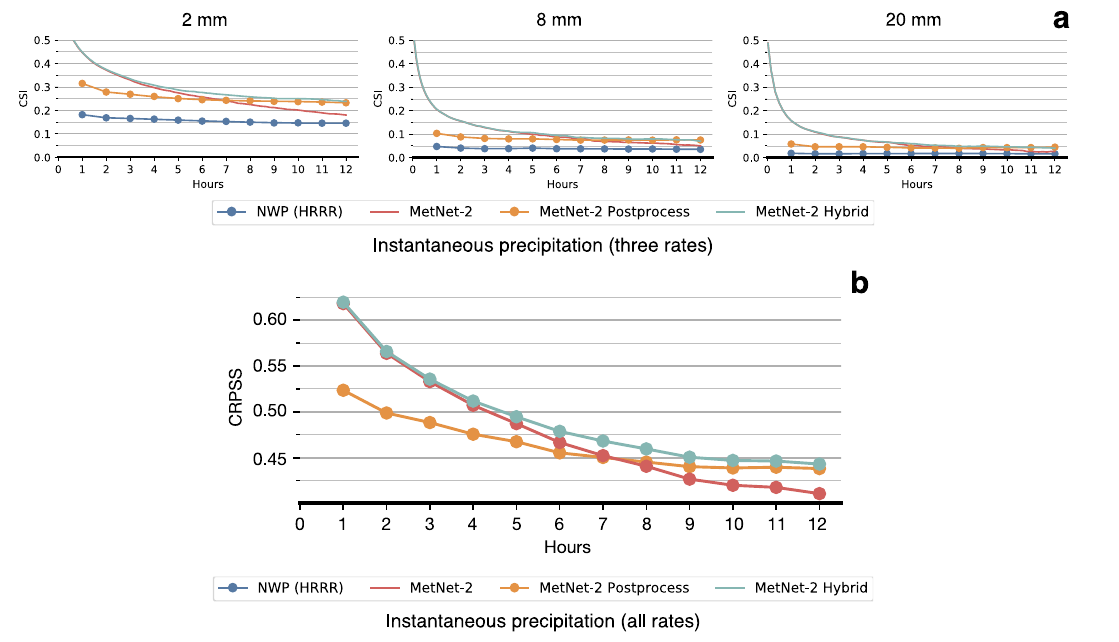
Fig. 5 | Evaluation of the models ’ performance on low and high rates of pre- cipitation (dataset B). Tables for the second main comparison between the MetNet-2 variant Hybrid and Postprocessing using CSI and Cumulative Ranked Probability Skill Score (CRPSS). HRRR and MetNet-2 included for